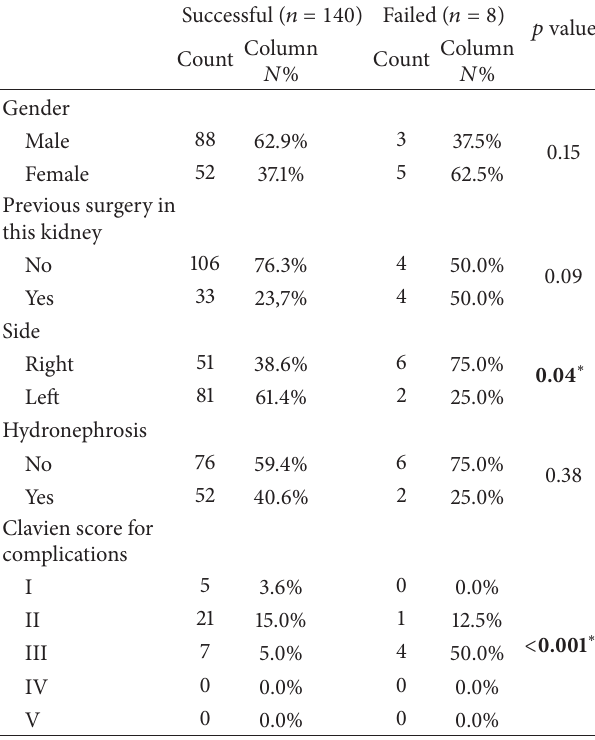
Table 3: Data of patients with failed operations compared with successful operations.